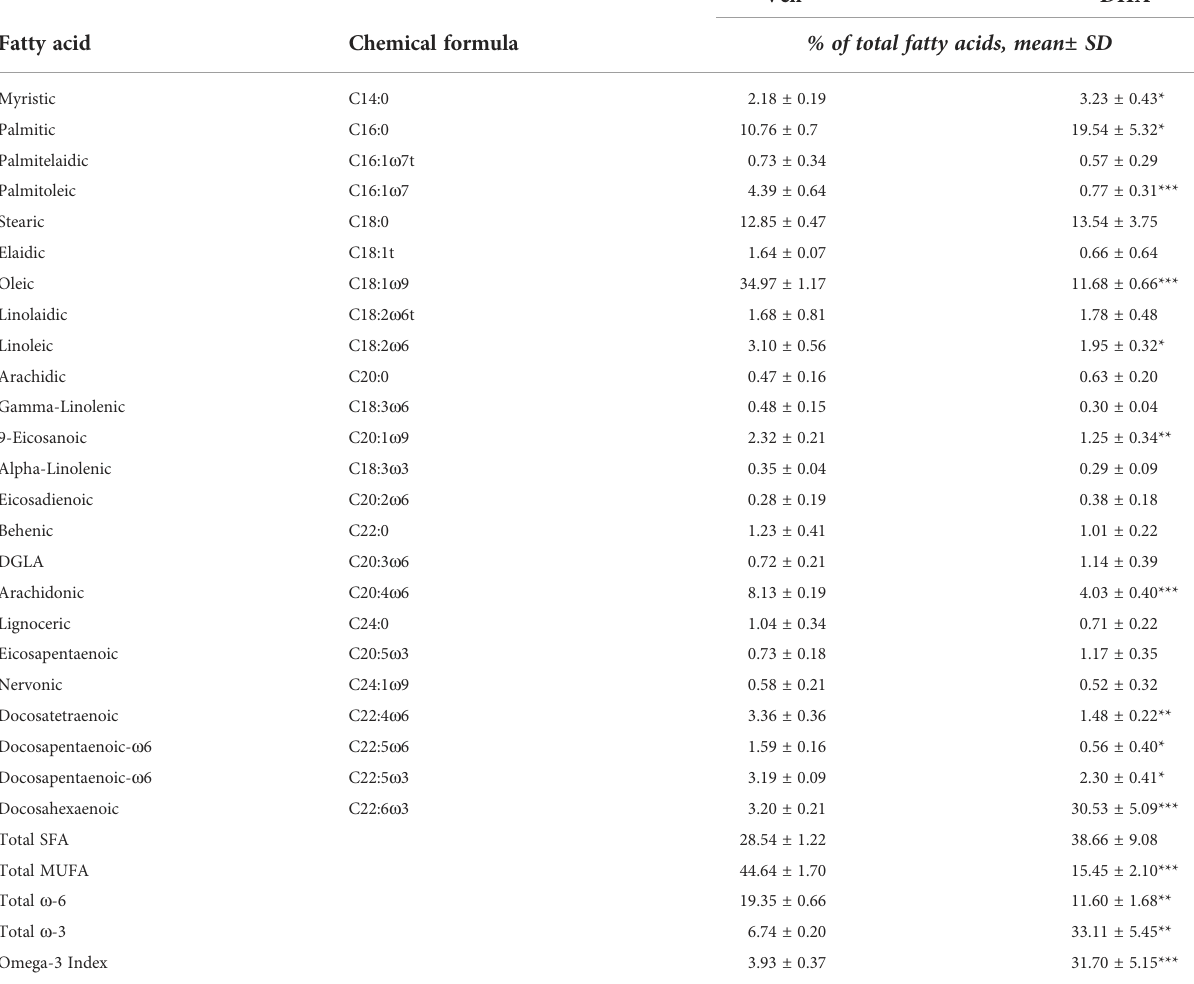
TABLE 1 Fatty acid composition of cells treated with Veh (BSA, 8.3 m M) or DHA-BSA complex (25 m M DHA, 8.3 m M